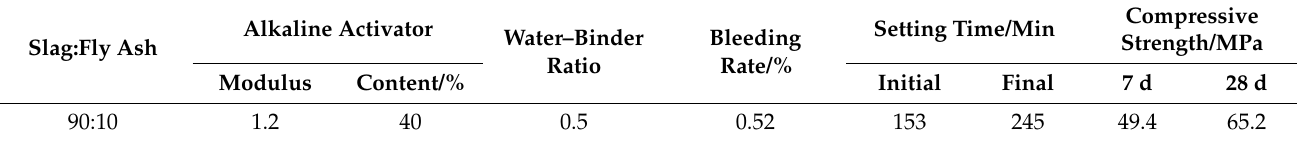
Table 3. Composition and basic properties of geopolymer.